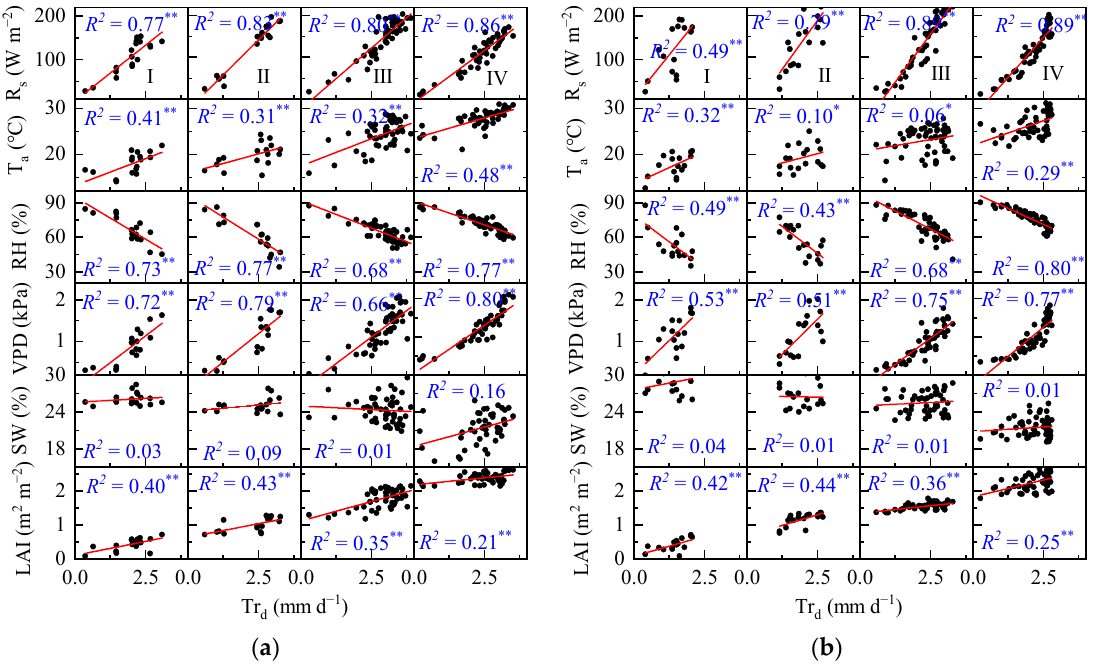
Figure 4. Correlation analysis between daily transpiration and environmental factors. ( a ) 2020; ( b ) 2021. * Indicates significant correlation between independent variable and dependent variable ( p < 0.05); ** Indicates highly significant correlation between independent variables and dependent variables ( p < 0.01). I, II, III, and IV respectively represent the new growth period, flowering and fruit setting period, fruit expansion period, and fruit maturation period.